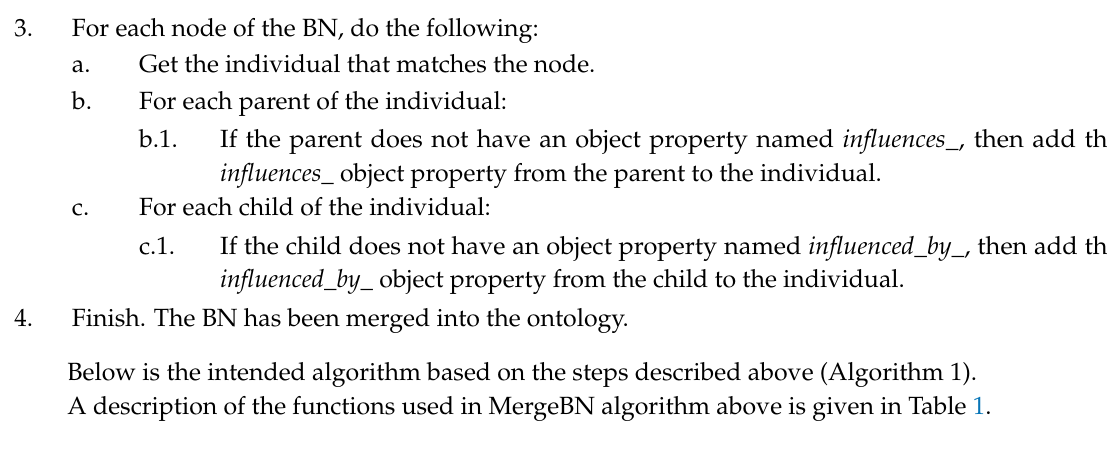
Table 1. Description of the functions used in the MergeBN